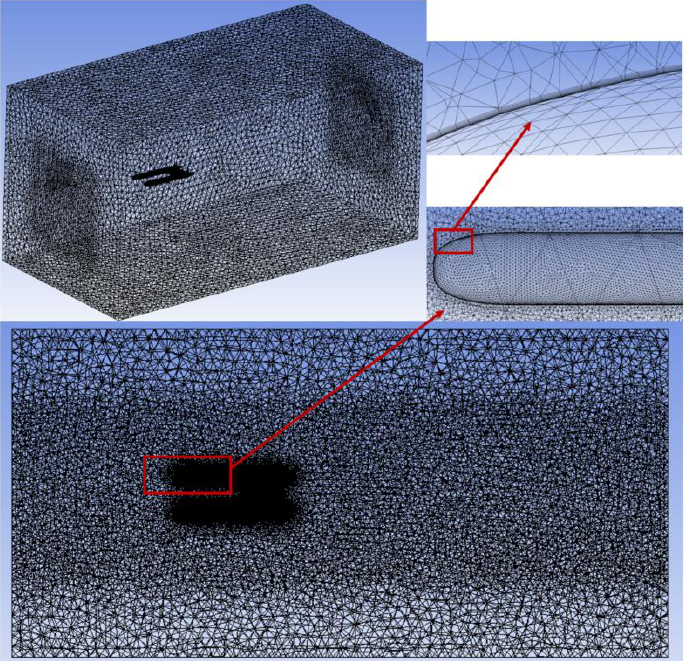
Figure 5. Non-structural grid of the CFD simulation.